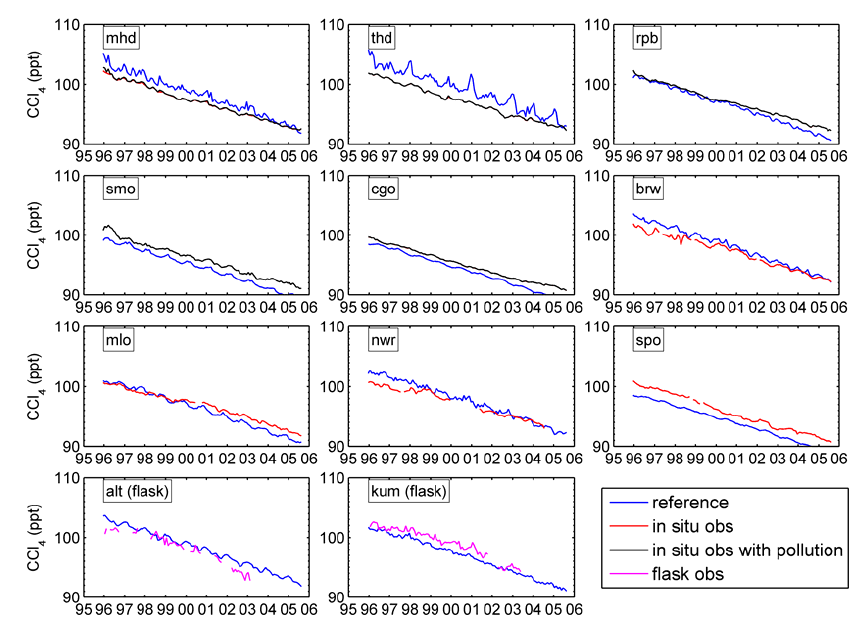
Fig. 5. The time series of the monthly mean CCl 4 mole fractions computed in the model using the a priori (reference) surface fluxes (industry source, ocean sink) are compared to the observations. Inclusion of observations that include pollution does not significantly alter the mole fractions on the inversions.